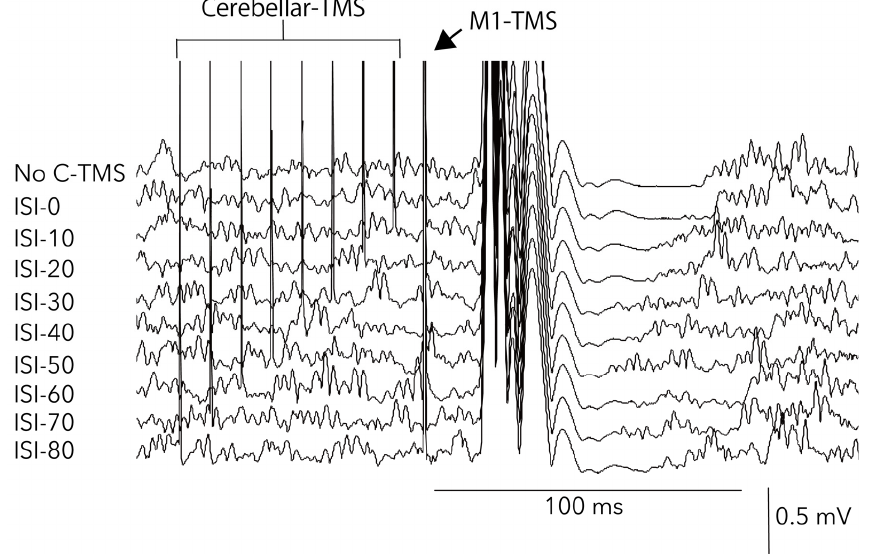
Figure 4. Sample averaged EMG waveforms in the second experiment. ISI, interstimulus interval; C-TMS, cerebellar transcranial magnetic stimulation; M1, primary motor cortex.